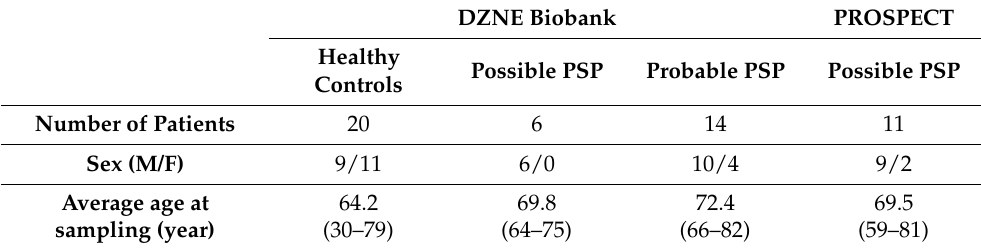
Figure 5. Flowchart of samples used in study. Table 1. Characteristics of the cohorts whose samples were used in this study. M/F: